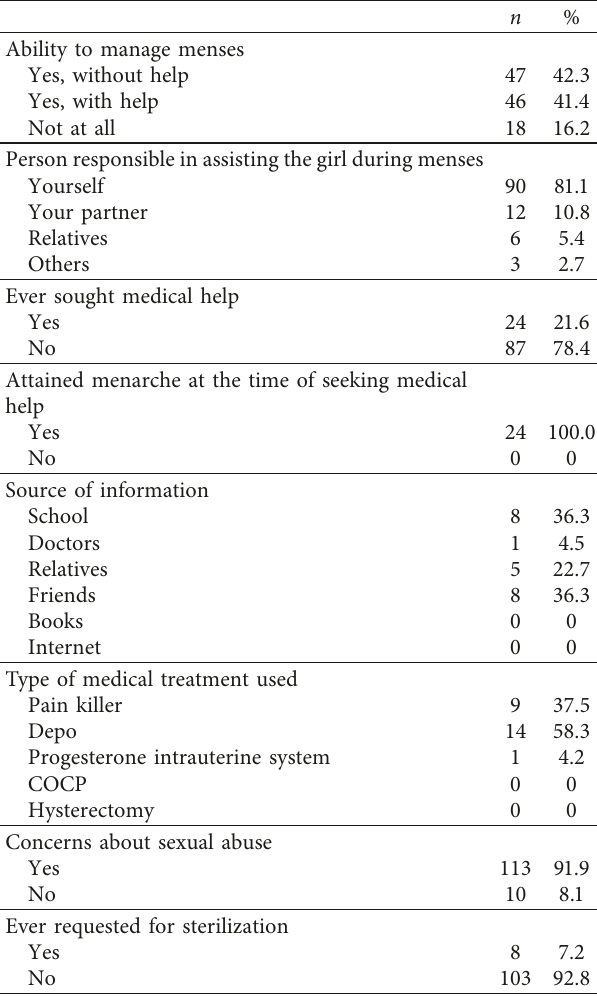
Table 1: Menstrual care for girls with intellectual